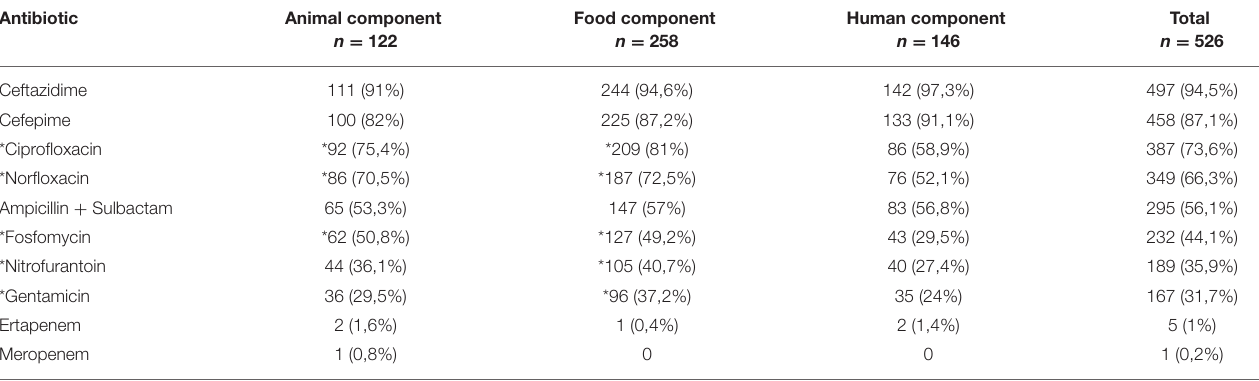
TABLE 1 | Antibiotic resistance rates in each component. Antibiotic